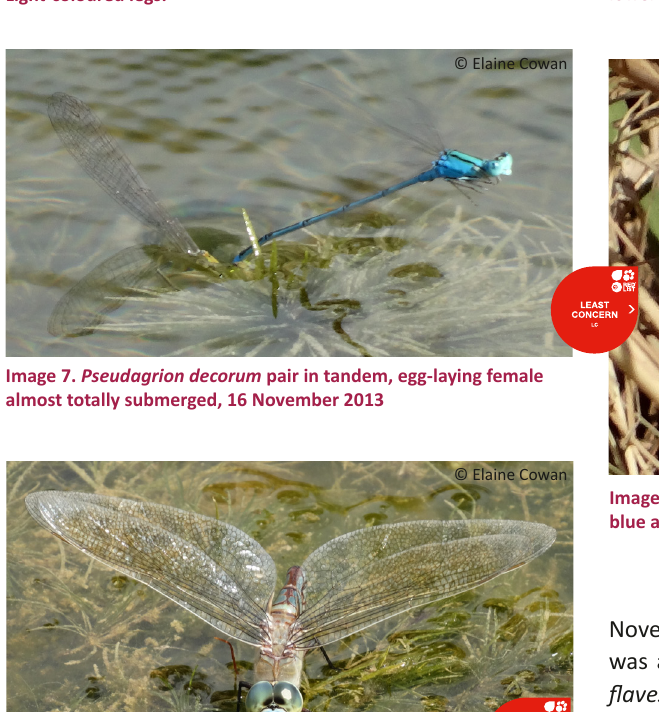
Image 6. Pseudagrion decorum mating wheel, 24 December 2013. Female: greenish face and upper thorax; underside of abdomen, lower face and lower sides of thorax pale blue-grey